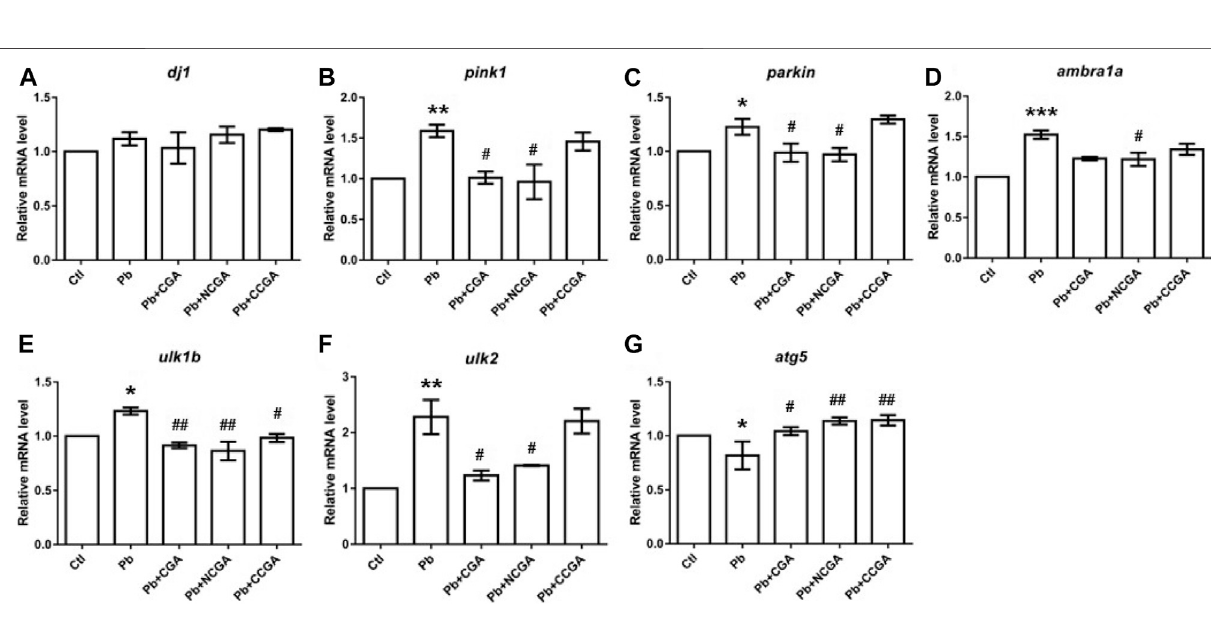
mRNA expression of pink1 ( Figure 9B ) and parkin ( Figure 9C ), respectively, whereas CCGA did not exert any signi fi cant modulation on pink1 and the parkin level. In comparison to the Pb group, NCGA signi fi cantly reduced ( # p < 0.05) the expression of ambra1a ( Figure 9D ), whereas CGA and CCGA exerted signi fi cant modulation in the same ( Figure 9D ). In